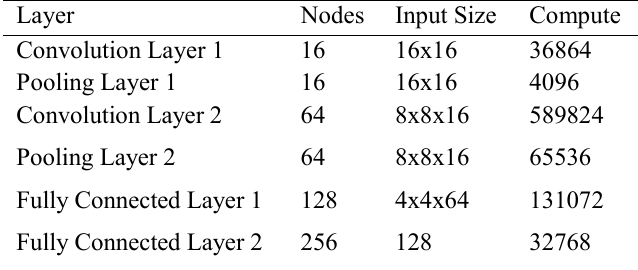
Table 1. CNN Per-Layer Compute